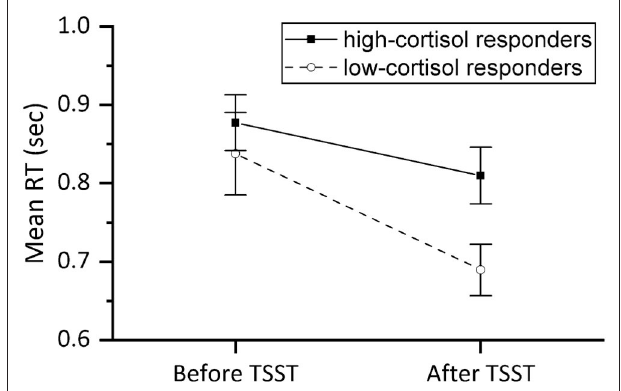
FIGURE 8 | Mean reaction time of valid responses in the PVT expressed in sec for high-cortisol responders ( n = 34) and low-cortisol responders ( n = 10). The results demonstrate that participants became less alert with progressing time giving rise to slower reactions. Error bars represent ± SE.